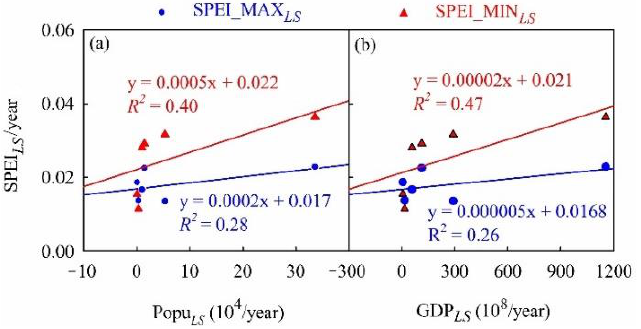
Figure 5. SPEI_MAX LS /SPEI_MIN LS vs. average Popu LS ( a ) and GDP LS ( b ) for different SDLs.